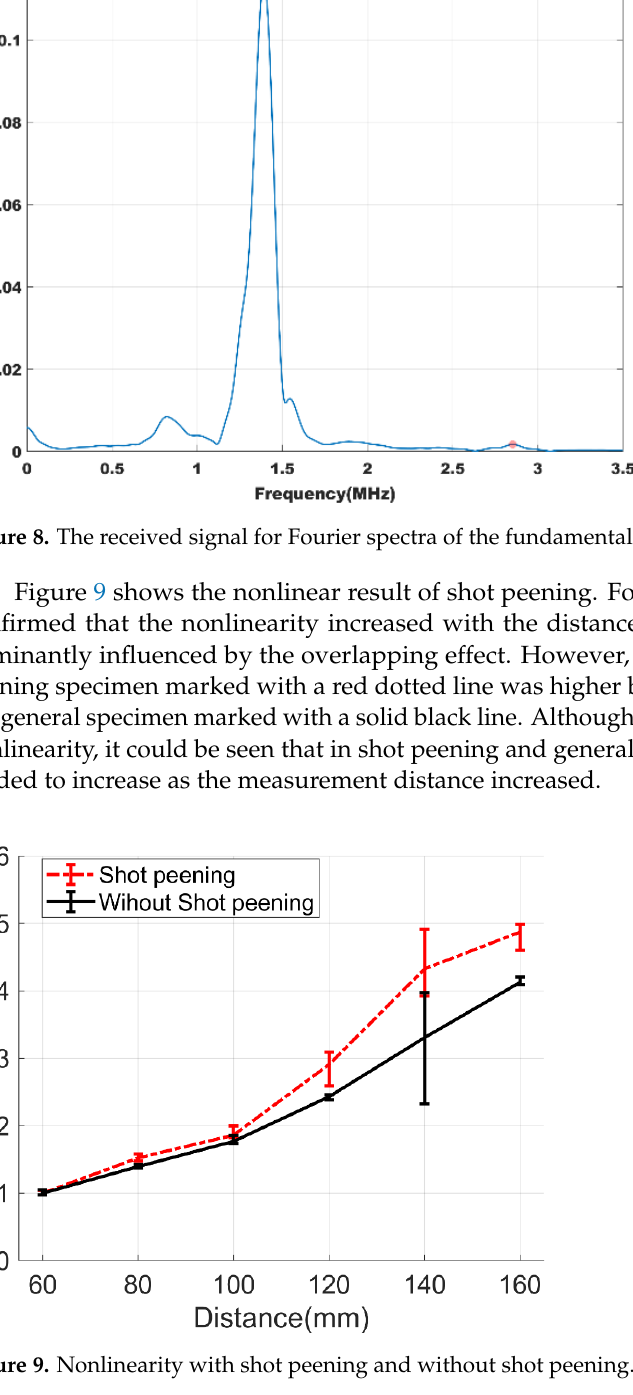
Figure 7. The received signal: time domain waveform.